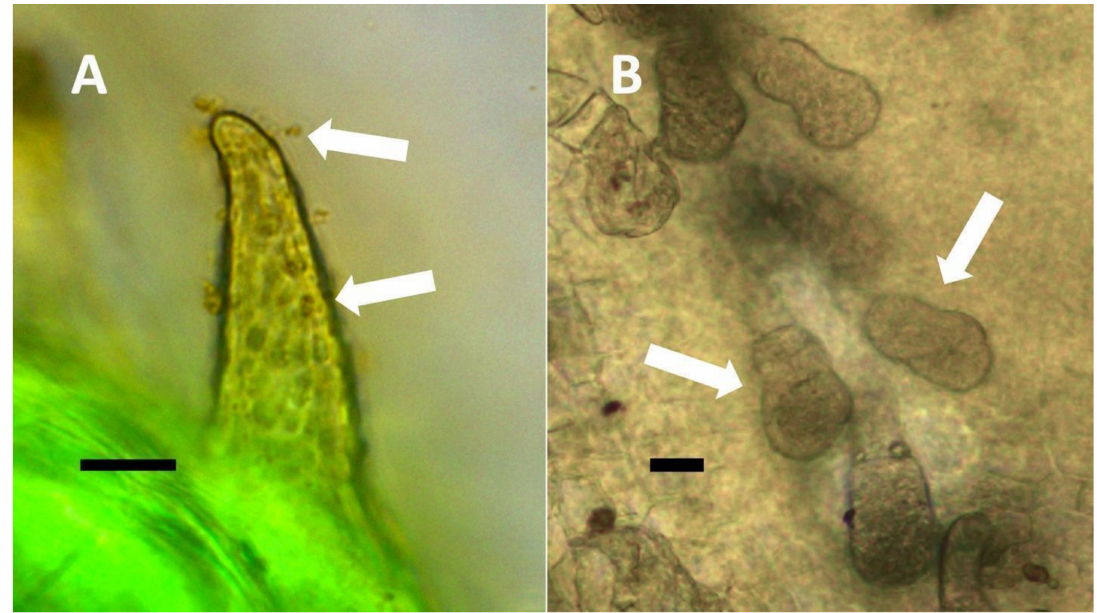
Figure 10. Leaf trichomes of Solanum dulcamara . ( A ) Developing pitted filamentous trichome stained with potassium permanganate to show ethylene (brown color) around bacteria (arrows) emerging from and within pits of trichome (arrow) (Bar = 10 µ m). ( B ) Glandular trichomes (arrows) along leaf veins stained with acidified diphenylamine to show nitrate (blue-purple color) in hairs (Bar = 10 µ